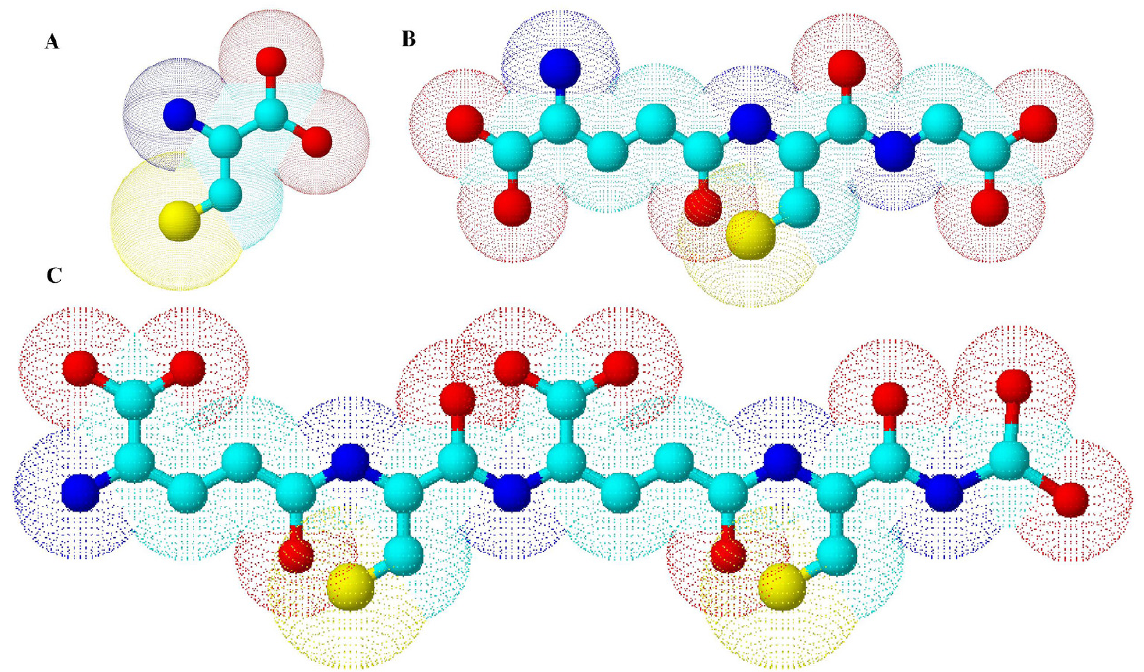
Figure 4. Model of (A) cysteine, (B) reduced glutathione and (C)